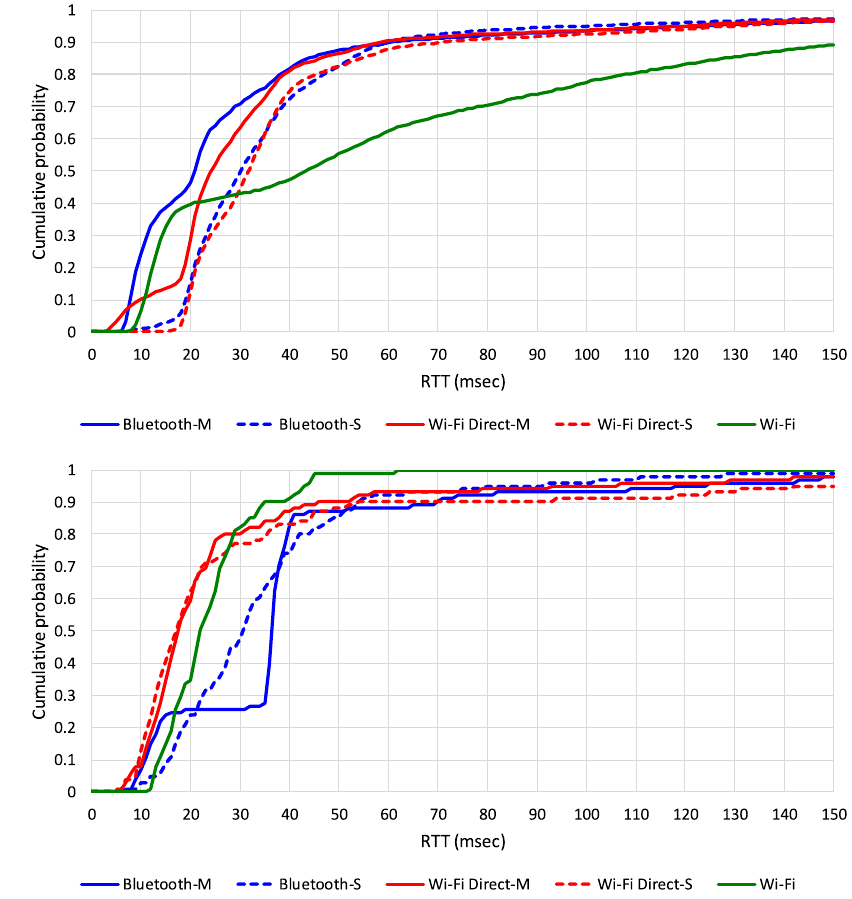
Fig. 7 All-RTT for all drawing operations (comparison based on communication standards)